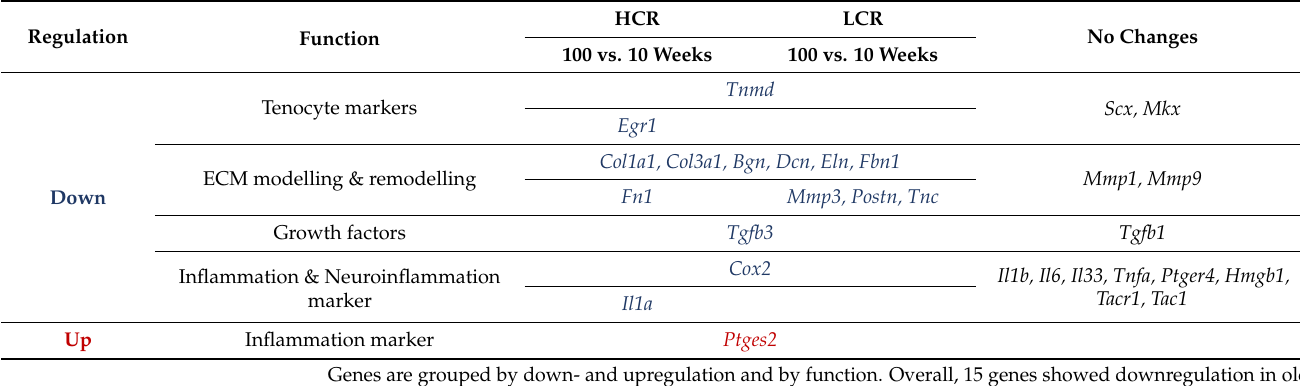
Table 2. Overview of investigated genes and significant alteration due to